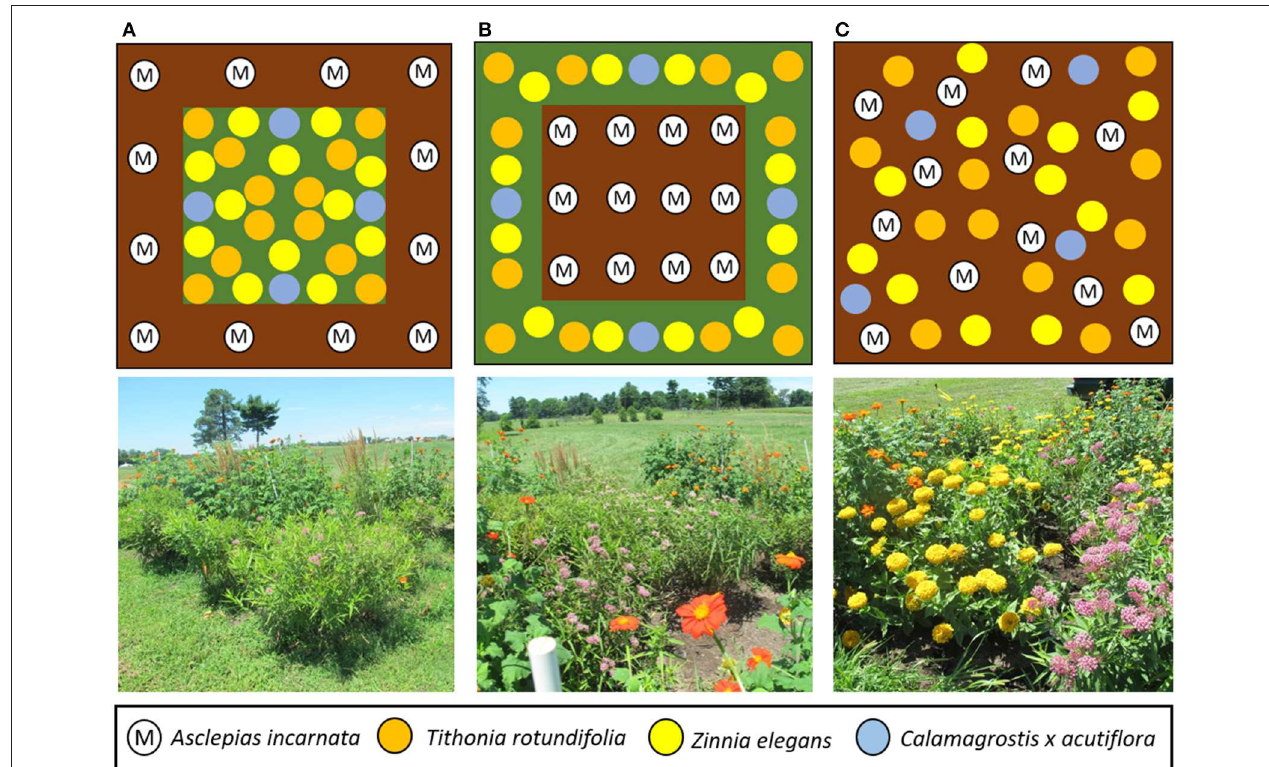
FIGURE 1 | Layout of the three garden designs tested. Top row, left to right: (A) milkweed plants on the perimeter of the garden (M), spacing with mulch (brown), nectar/camouflage plants on interior of garden [ Tithonia rotundifolia (orange), Zinnia elegans (yellow), and Calamagrostis x acutiflora (blue)]; (B) milkweed on the interior of the garden and placement of the nectar/camouflage plants on exterior of garden; (C) no formal design to simulate a naturalized or mixed garden. Milkweed and nectar/camouflage plants were placed randomly throughout each quadrant in the gardens. Bottom row, left to right: gardens of the aforementioned designs, respectively, as they appeared in